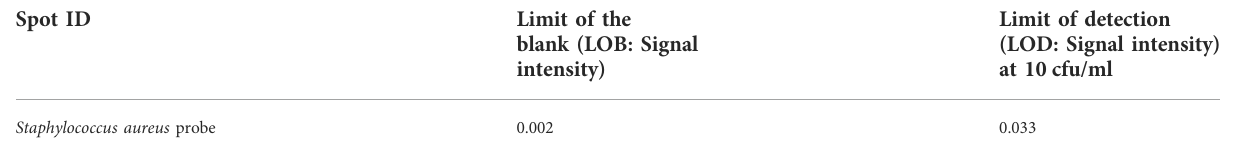
TABLE 4 Limit of Blank (LOB) and Limit of Detection (LOD) calculated for all the corresponding probe for Staphylococcus aureus . Spot ID Limit of the